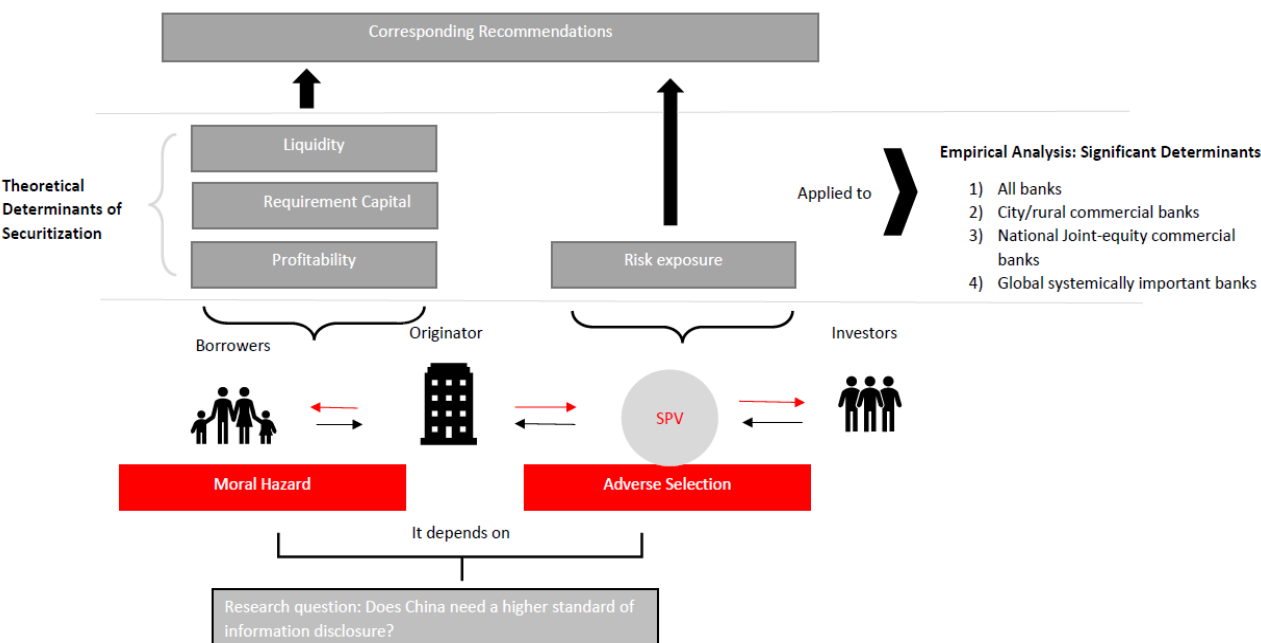
Figure 1. Framework of the study.